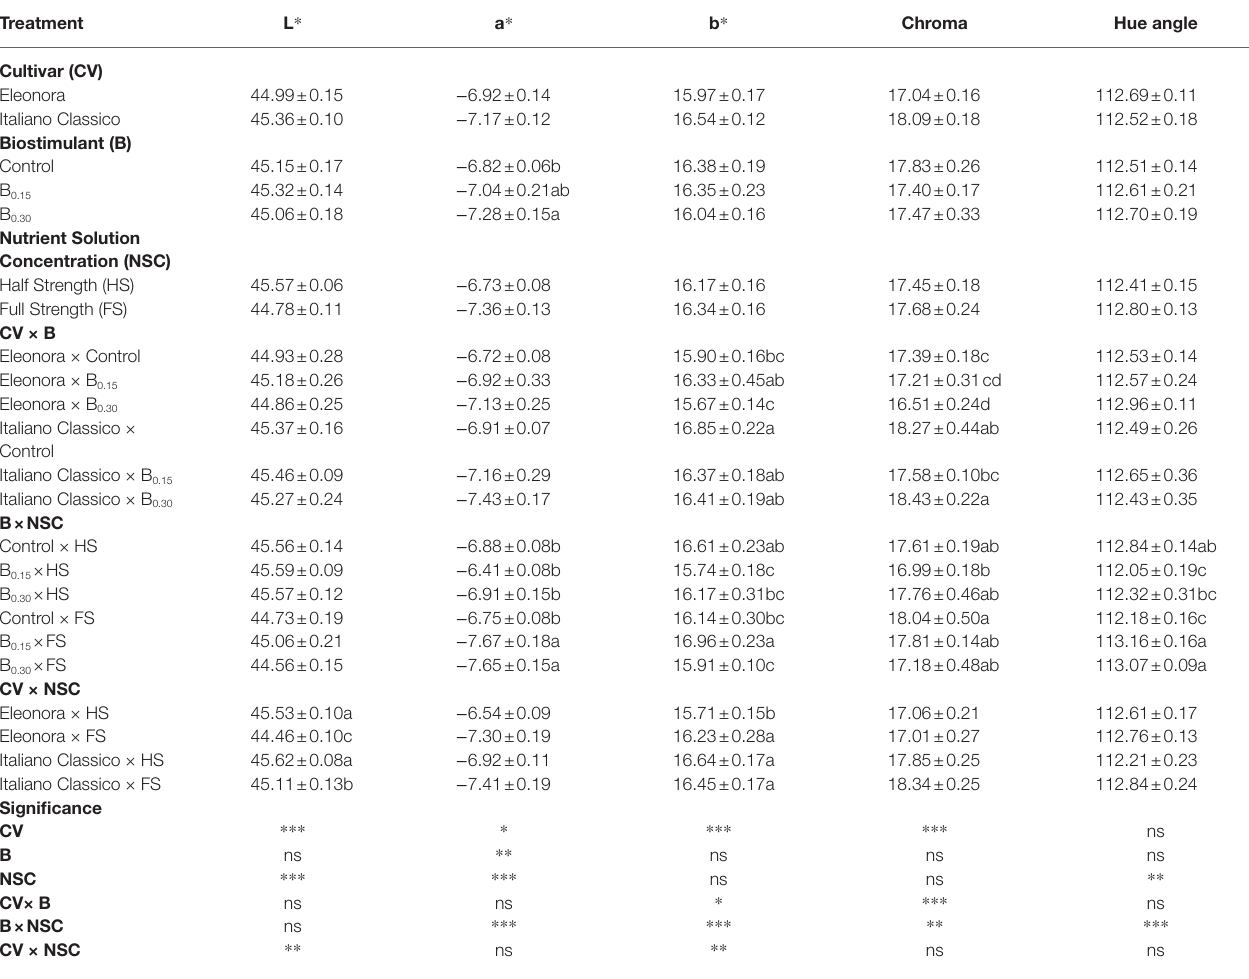
TABLE 2 | Analysis of variance and mean comparisons for CIELab colorimetric parameters of Eleonora and Italiano Classico genotypes grown hydroponically under two nutrient solution and dose of biostimulant. Treatment L * a * Chroma Hue angle Cultivar (CV)